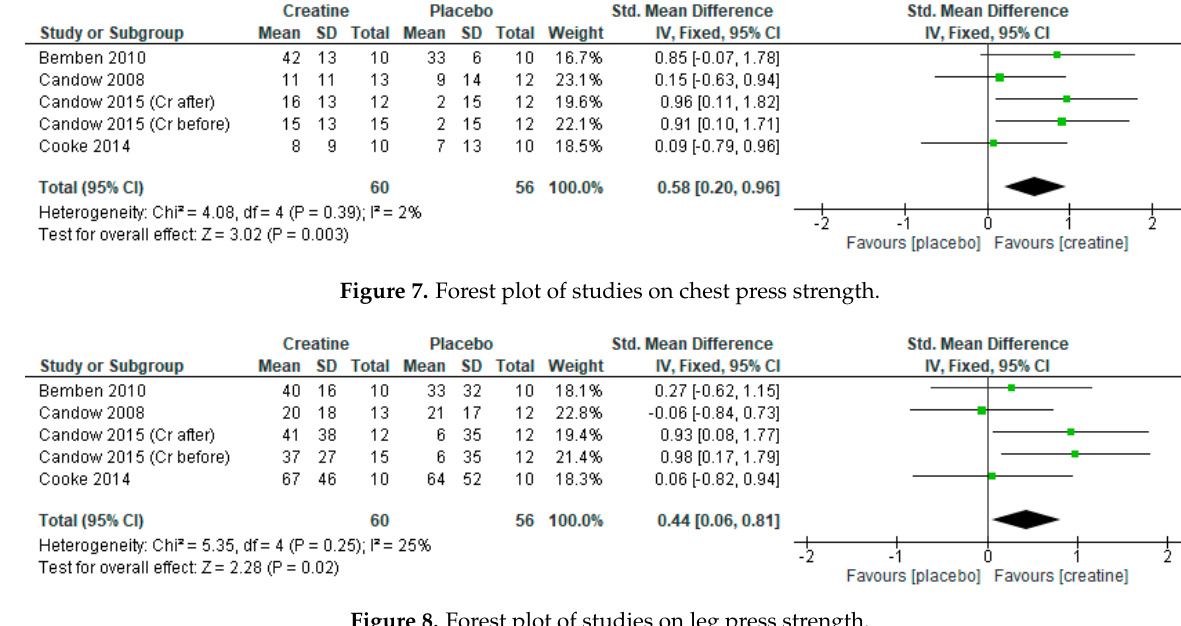
Figure 8. Forest plot of studies on leg press strength.